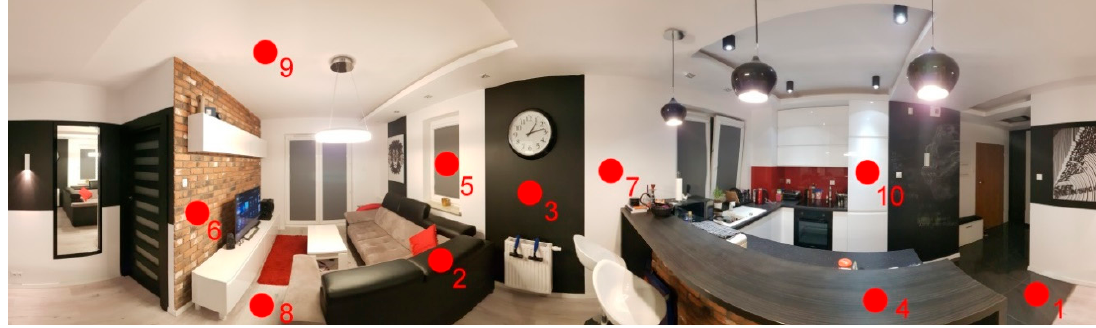
Figure 4. Layout of luminance measuring points in interior. Table 1. Luminance levels at measuring points [62].